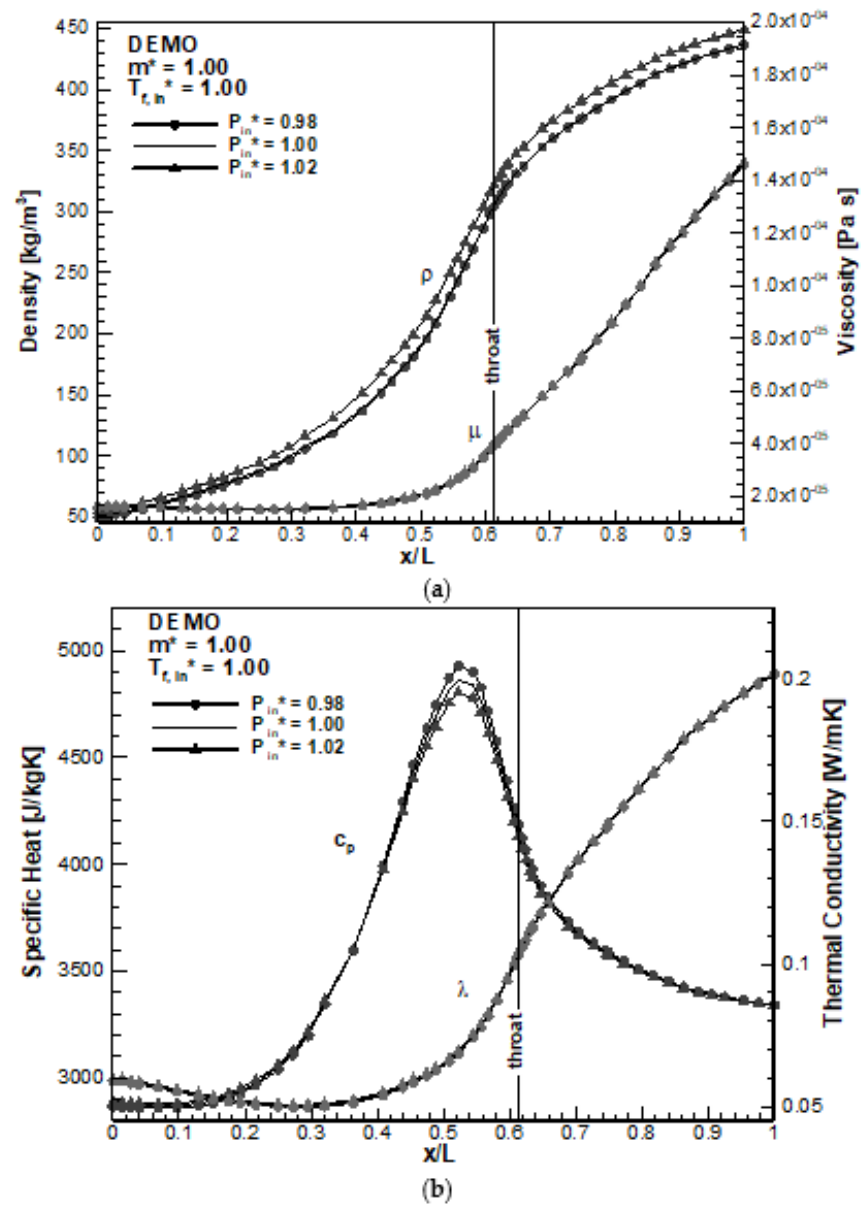
Figure 22. Axial profiles of thermophysical properties, considering the effects of inlet pressure (runs 1, 5, 6): ( a ) density and viscosity; ( b ) specific heat and thermal conductivity.